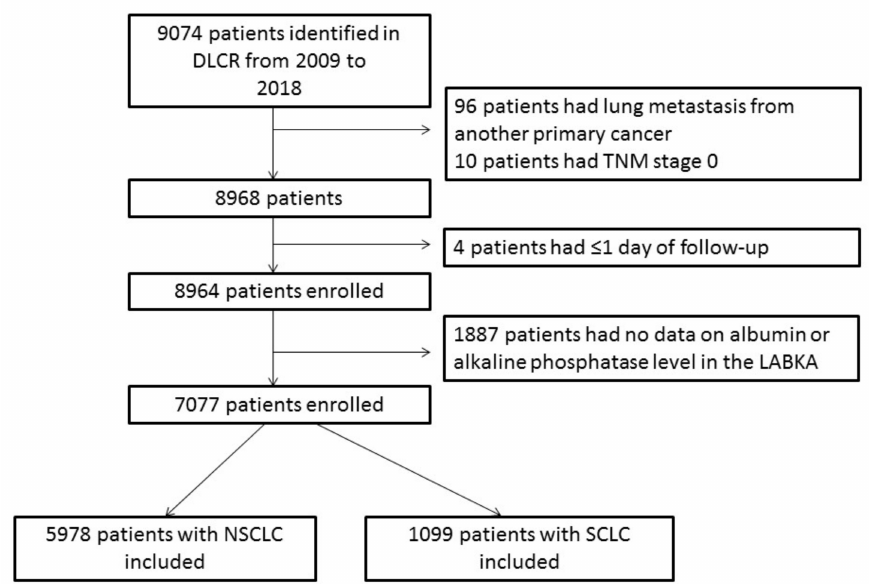
Figure 1. Flow chart of inclusion and exclusion of patients. Abbreviations: DLCR, Danish Lung Cancer Group; TNM, tumor node metastasis; LABKA, clinical laboratory information system; NSCLC, non-small cell lung cancer; SCLC, small cell lung cancer.